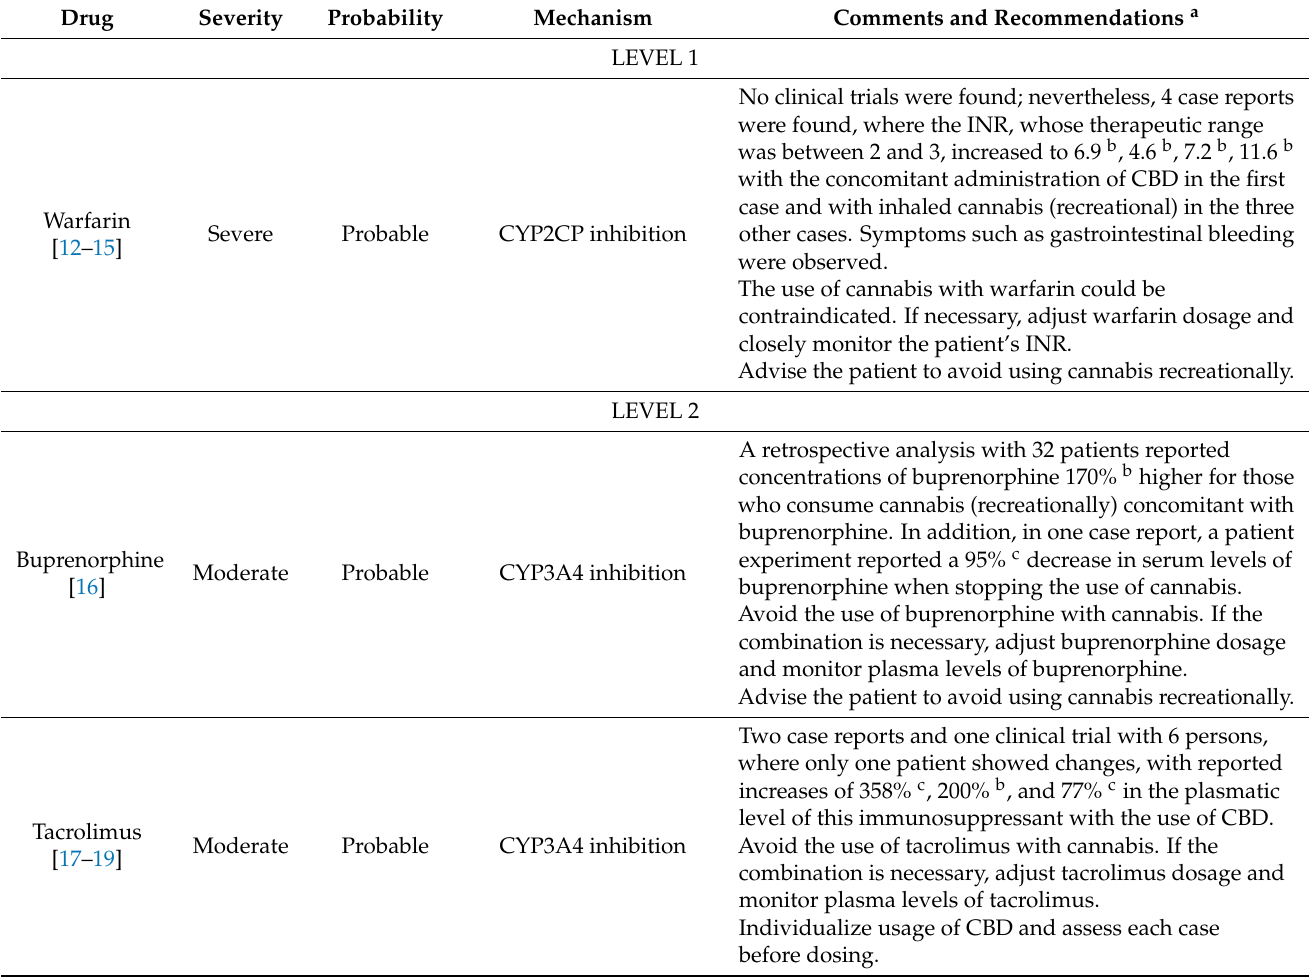
Table 3. Interactions between cannabis and